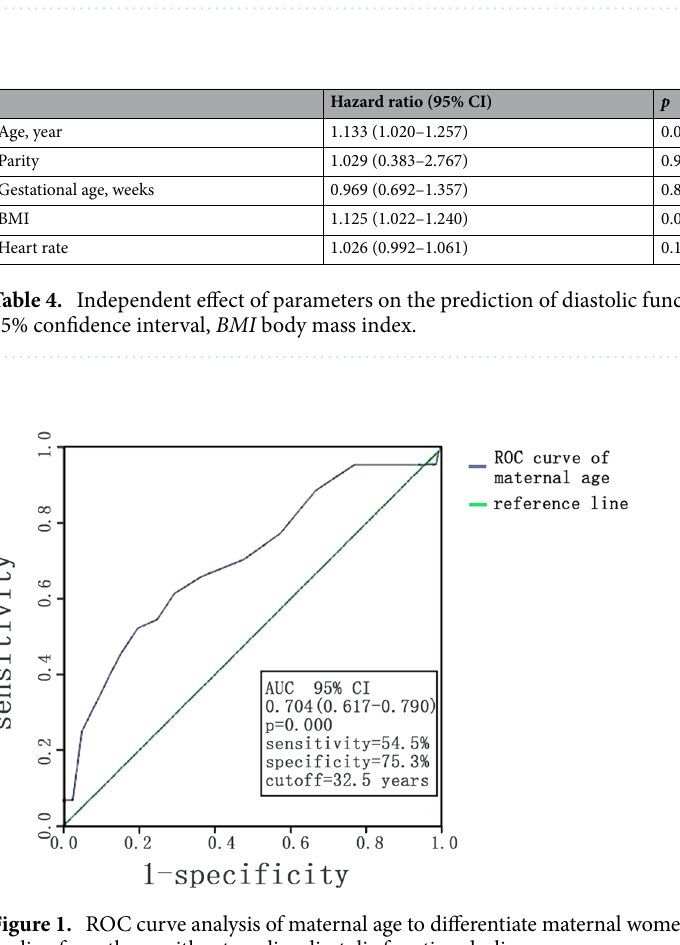
Table 3. Independent effect of maternal age on the echocardiographic indices. LAD left atrial diameter, LAA left atrial area, Em peak early diastolic myocardial velocity, E/Em ratio of Peak velocity blood flow in early diastole to peak early diastolic myocardial velocity.